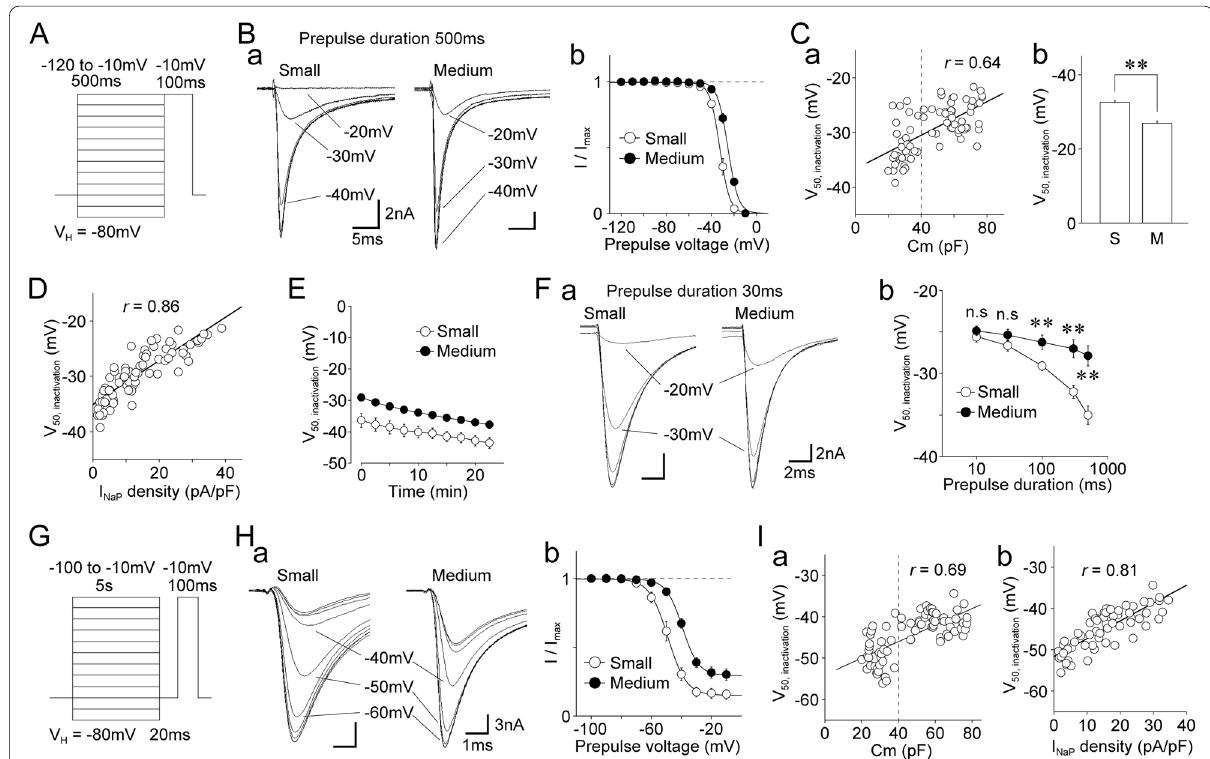
Fig. 3 Voltage‑inactivation relationships of TTX‑R Na + channels in dural afferent neurons. A. Schematic illustration of voltage step pulses for the steady‑state fast inactivation of TTX‑R Na + channels. Conditioning prepulses (500 ms duration; ‑120 mV to ‑10 mV in 10 mV increments) were immediately followed by test pulses (100 ms duration; up to ‑10 mV). B. a , Typical traces of TTX‑R I Na elicited by step pulses shown in A obtained from small‑ (left) and medium‑sized (right) DiI‑positive neurons. b , Voltage‑inactivation relationships of TTX‑R Na + channels in small‑ (open circles) and medium‑sized (closed circles) DiI‑positive neurons. The points and error bars represent the mean and SEM from 32 small‑ and 44 medium‑sized DiI‑positive neurons. The continuous lines represent the best fits using a Boltzmann function. C. a , Scatter plot of the half‑maximal voltage for inactivation (V 50, inactivation ) against membrane capacitance (Cm) ( n 76). The linear trend line represents the best fit using a least‑squares fit = ( r 0.64). b , The mean values of the V 50, inactivation in small‑ (S) and medium‑sized (M) DiI‑positive neurons. The columns and error bars represent the = mean and SEM from 32 small‑ and 44 medium‑sized DiI‑positive neurons. **; p < 0.01 (unpaired t‑test). D. Scatter plot of the half‑maximal voltage for inactivation (V 50, inactivation ) against the density of TTX‑R I NaP ( n 76). The linear trend line represents the best fit using a least‑squares fit ( r 0.86). E. = = Time‑dependent changes in V 50, inactivation immediately after making a membrane rupture in small‑ (open circles) and medium‑sized (closed circles) DiI‑positive neurons. The points and error bars represent the mean and SEM from six small‑ and eight medium‑sized DiI‑positive neurons. F. a , Typical traces of TTX‑R I Na elicited by voltage step pulses in small‑ (left) and medium‑sized (right) DiI‑positive neurons. TTX‑R I Na were elicited by test pulses (100 ms duration; up to ‑10 mV) immediately after conditioning prepulses (10–500 ms duration; ‑120 mV to ‑10 mV in 10‑mV increments). b , Changes in V 50, inactivation with various durations (10–500 ms) of depolarizing prepulses. The points and error bars represent the mean and SEM from six small‑ and eight medium‑sized DiI‑positive neurons. **; p < 0.01, n.s; not significant (unpaired t‑test). G. Schematic illustration of voltage step protocols for the slow inactivation of TTX‑R Na + channels. The conditioning prepulses (5 s duration, ‑100 mV to ‑10 mV, 10 mV increments) were followed by the test pulses (100 ms duration, up to ‑10 mV) with an interval of 100 ms at a potential of ‑80 mV. H. a , Typical traces of TTX‑R I Na elicited by voltage step pulses in small‑ (left) and medium‑sized (right) DiI‑positive neurons. b , Voltage‑slow inactivation relationships of TTX‑R Na + channels in small‑ (open circles) and medium‑sized (closed circles) DiI‑positive neurons. The points and error bars represent the mean and SEM from 32 small‑ and 44 medium‑sized DiI‑positive neurons. The continuous lines represent the best fits using a Boltzmann function. I. Scatter plots of the half‑maximal voltage for inactivation (V 50, inactivation ) against membrane capacitance (Cm) ( a , n 76) and the density of TTX‑R I NaP ( b , n 76). The = = linear trend lines represent the best fits using a least‑squares fit ( a , r 0.69; b , r = =